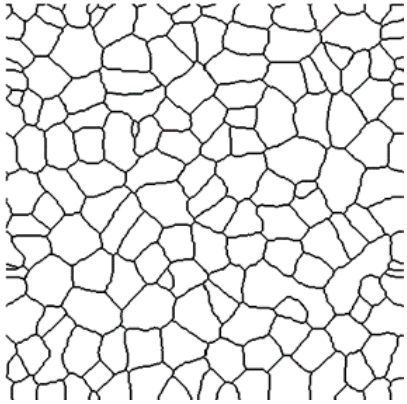
Figure 7. The initial microstructure of the 5754 aluminium alloy.